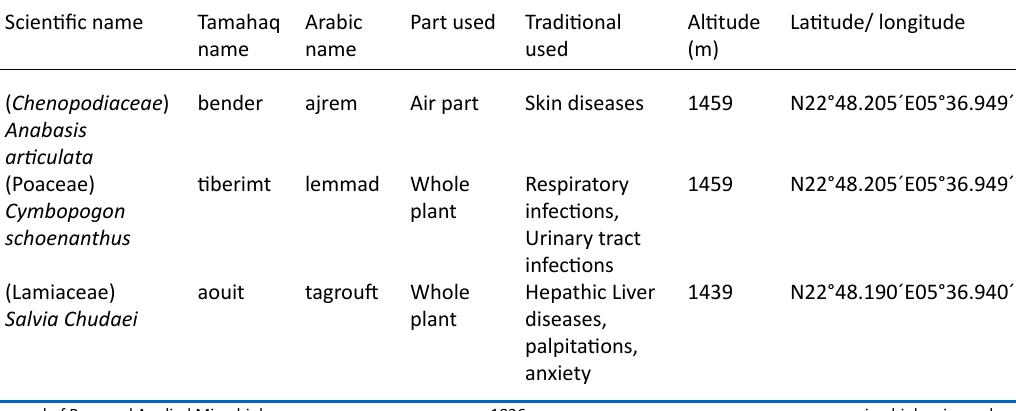
Table 1. Locations, name and folkloric uses of plants subject of our study 6